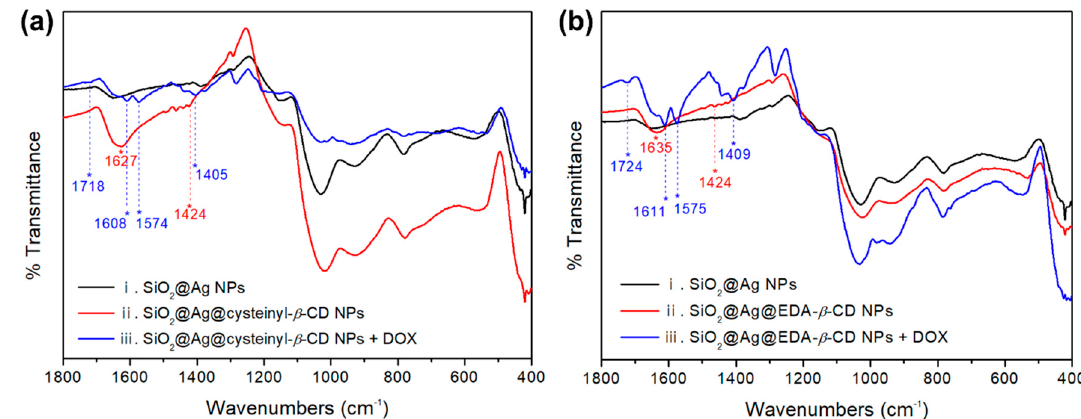
Figure 4. FTIR spectra confirming the introduction of cysteinyl- β -CD, EDA- β -CD, and DOX on SiO 2 @Ag NPs. ( a ) Immobilized cysteinyl- β -CD (N–H bending vibration at 1627 cm − 1 , CH 2 bending vibration at 1424 cm − 1 , red) on the SiO 2 @Ag NPs and DOX (ketone group stretching at 1718 cm − 1 , C=C stretching vibration at 1608 cm − 1 and 1574 cm − 1 , and methyl group bending at 1403 cm − 1 , blue) on SiO 2 @Ag@cysteinyl- β -CD NPs. ( b ) Immobilized EDA- β -CD (N–H bending vibration at 1635 cm − 1 , CH 2 bending vibration at 1424 cm − 1 , red) on SiO 2 @Ag NPs and DOX (ketone group stretching at 1724 cm − 1 , C=C stretching vibration at 1611 cm − 1 and 1575 cm − 1 , methyl group bending at 1409 cm − 1 , blue) on SiO 2 @Ag@EDA- β -CD NPs. (i) SiO 2 @Ag NPs, (ii) SiO 2 @Ag@cysteinyl- β -CD NPs and SiO 2 @Ag@EDA- β -CD NPs, (iii) NPs after loading DOX onto SiO 2 @Ag@cysteinyl- β -CD NPs and SiO 2 @Ag@EDA- β -CD NPs.